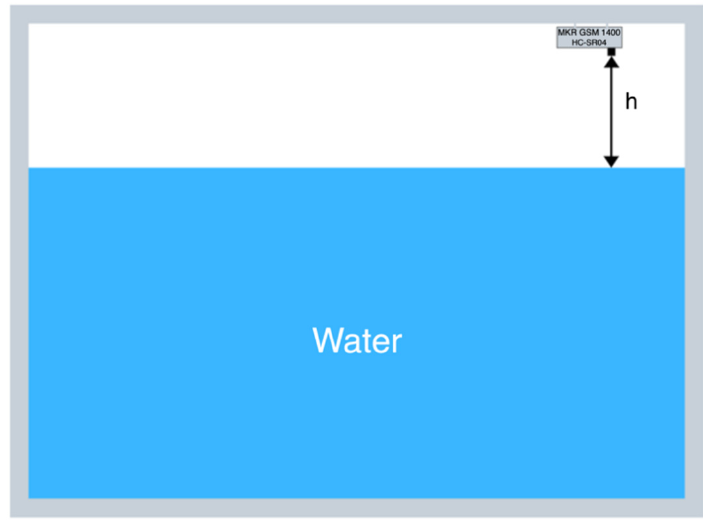
Figure 7. The tank level monitoring system.